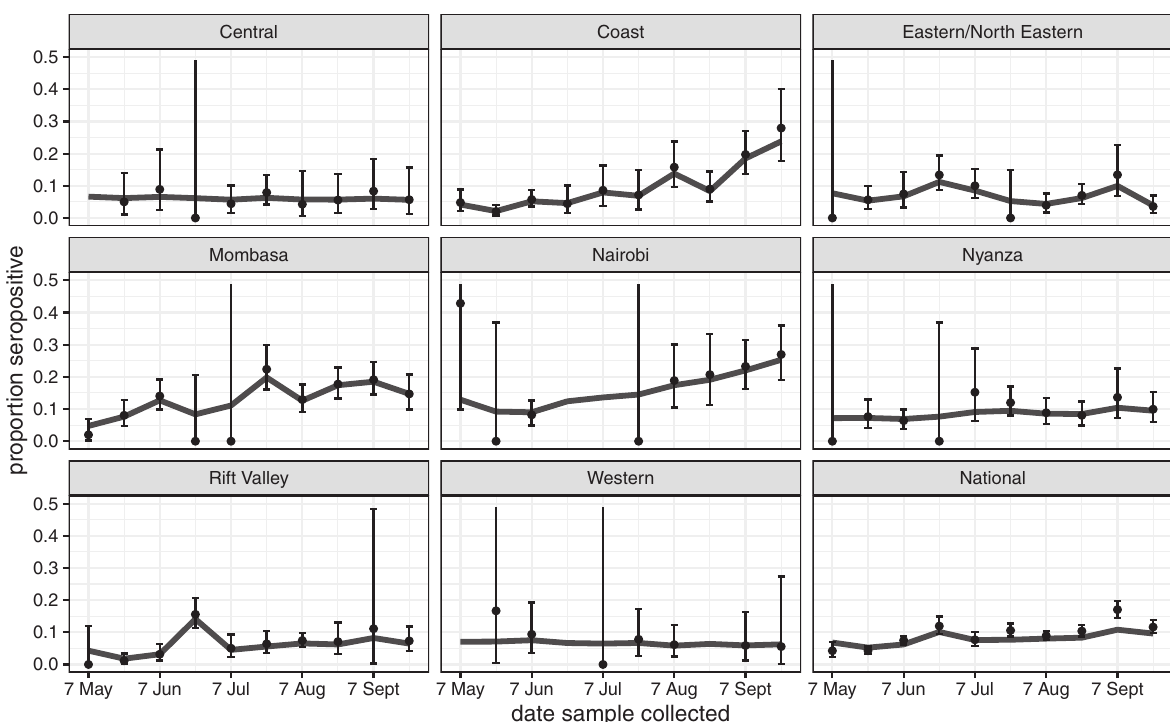
Fig. 2 Seroprevalence positivity across the study period by region. The fi gure shows unadjusted estimates (black dots) and Bayesian model estimates (grey line) of seroprevalence in 8 regions of Kenya and overall, by date of sample collection in 10 periods of ~2 weeks each during 2020 ( n = 9992). With the exception of the fi rst period in Rift Valley (7 May) and 6th period in Eastern/North Eastern (21 July), all data estimates of zero prevalence are based on small sample sets (<20 samples). Error bars are 95% Con fi dence Intervals.